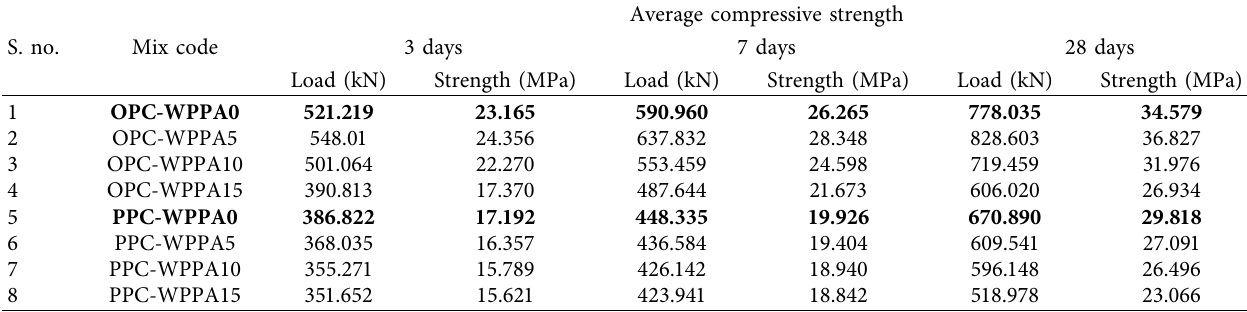
Table 11: Compressive strength of OPC-WPPA and PPC-WPPA concrete.